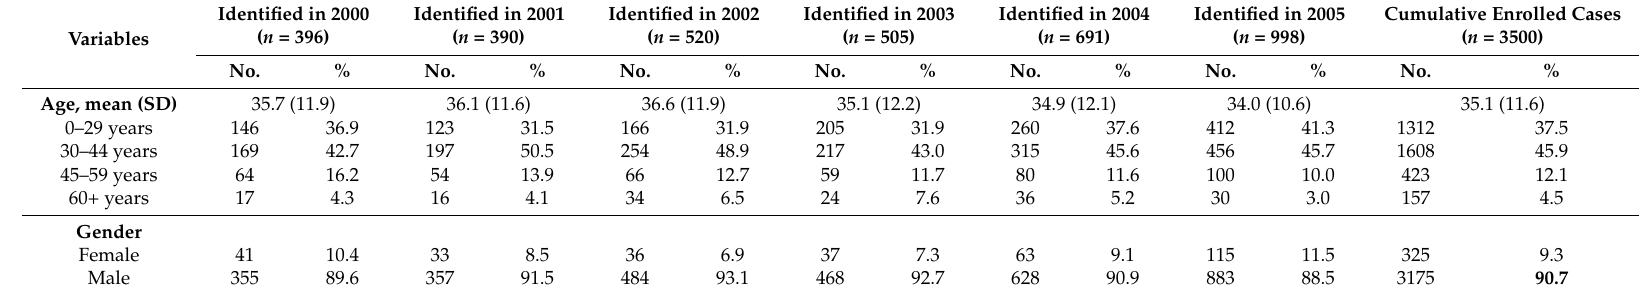
Table 1. Dynamic inclusive cohort of people newly-diagnosed with HIV * enrolled in the present study in Taiwan during 2000–2005.